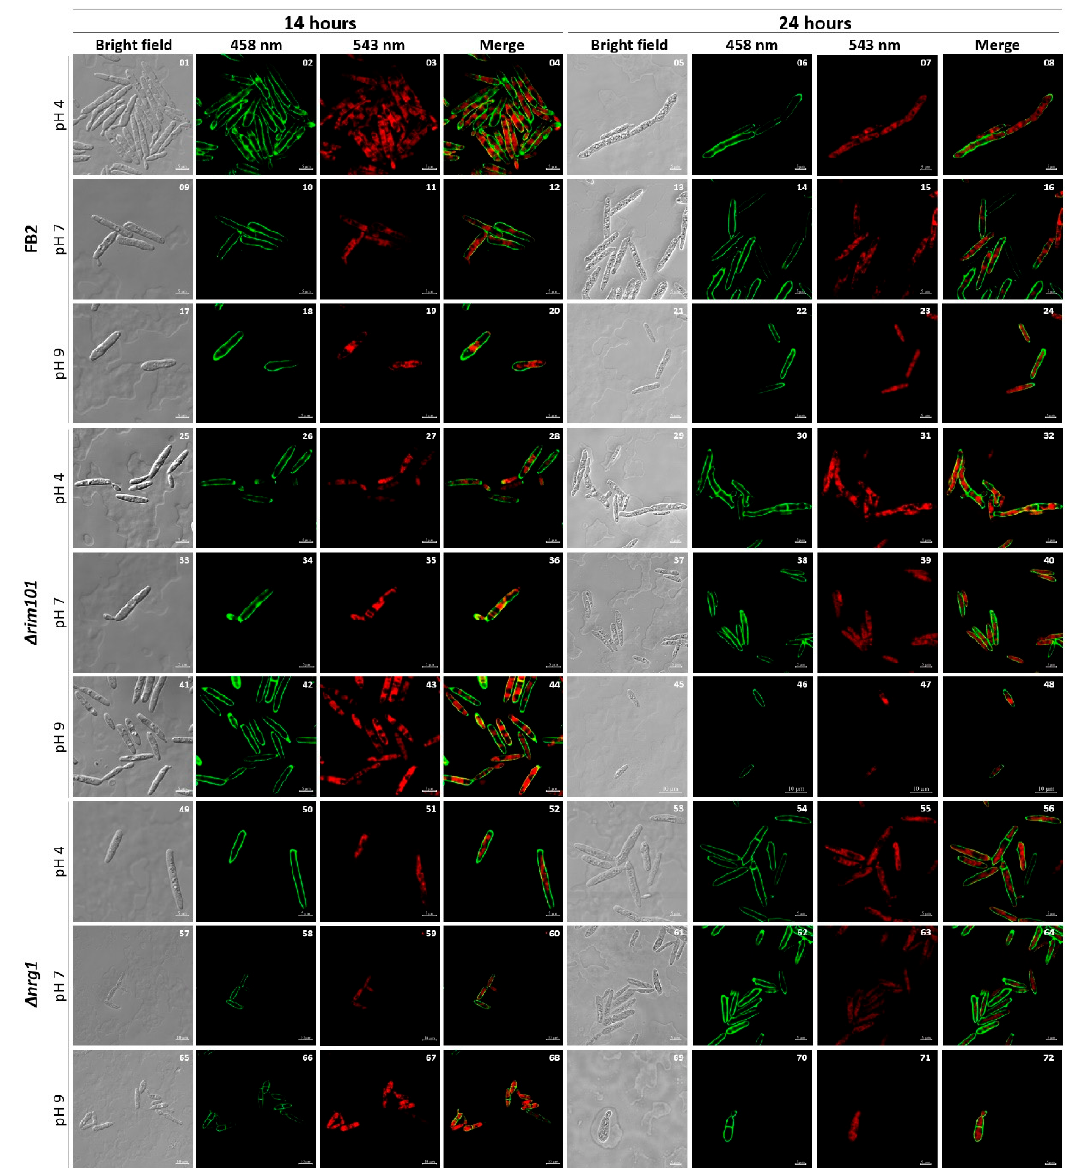
Figure 2. FB2, Δ rim101 and Δ nrg1 strains cell morphology. Cells of wild type (control), BMA2 and FMA2 were grown at pH 4, pH 7 and pH 9. After 14 h and 24 h of growth, they were photographed. Cells were stained with propidium iodide chromosomal content and with solophenylflavine to detect fungal cell walls and septum. The scale bar represents 10 µm. The experiment was done in triplicate.